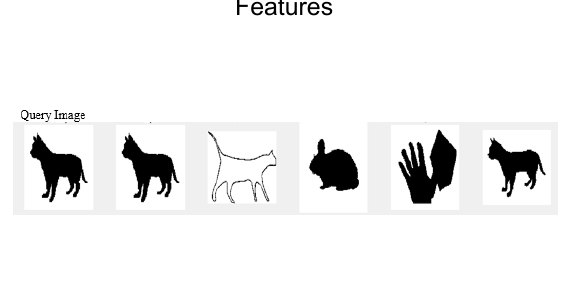
Figure 10. Image2 retievals using Moment Based Features